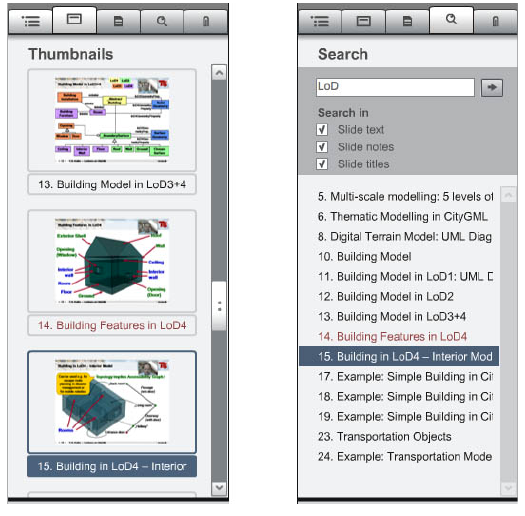
Figure 4a (left): Slide access by thumbnail Figure 4b: Search function and list of results